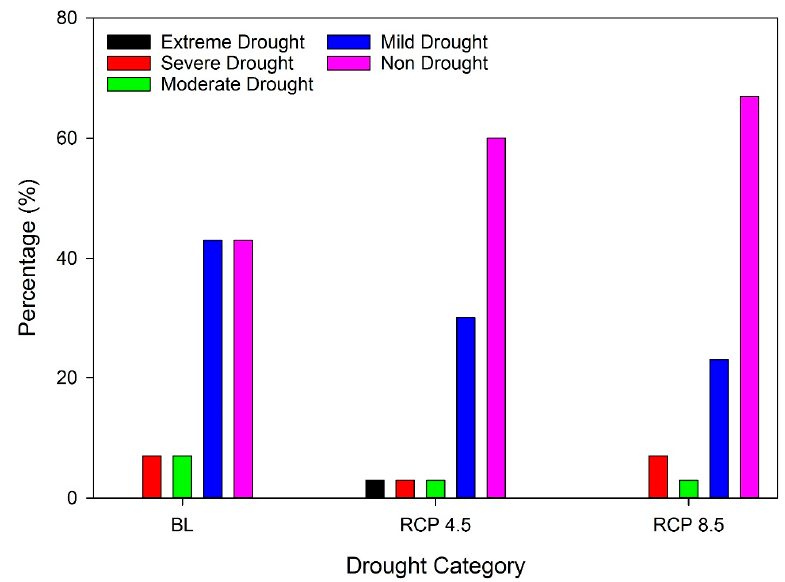
Figure 12. Percentage of time in each drought category under baseline and late-century conditions. (BL denotes baseline).